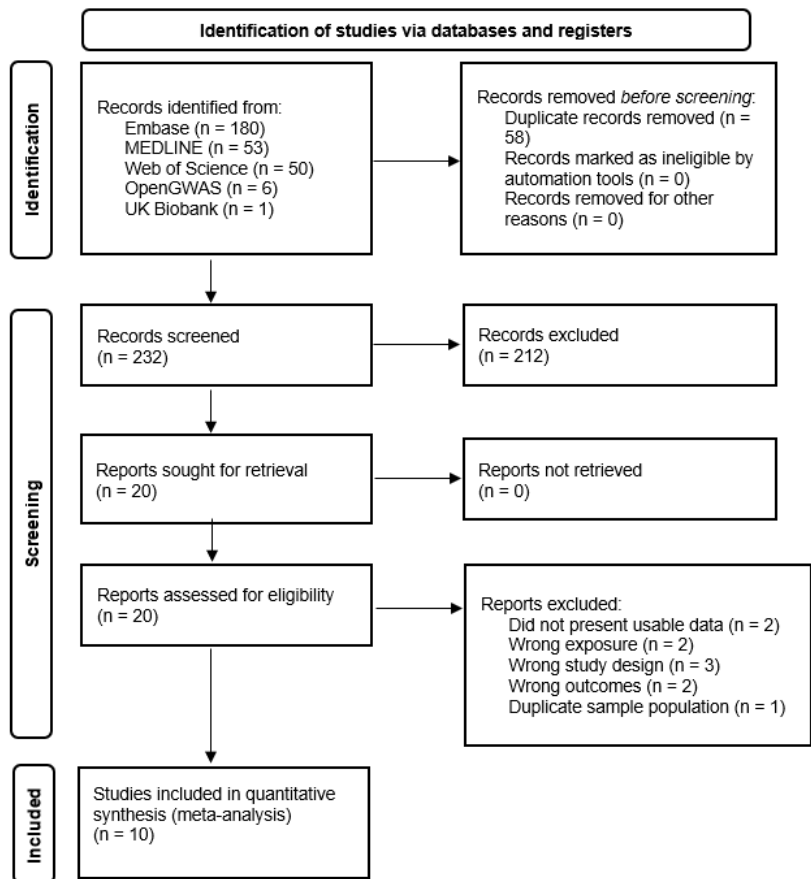
Figure 1. Flowchart illustrating the literature search and study